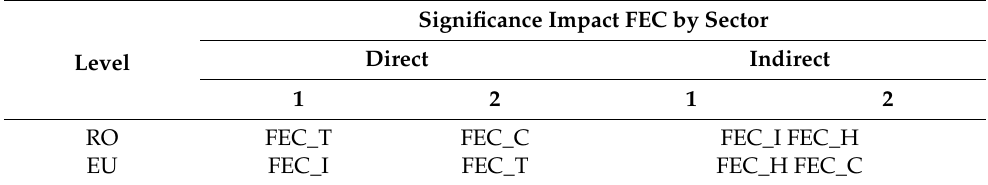
Table 7. Impact of sector-specific final energy consumption on economic growth.